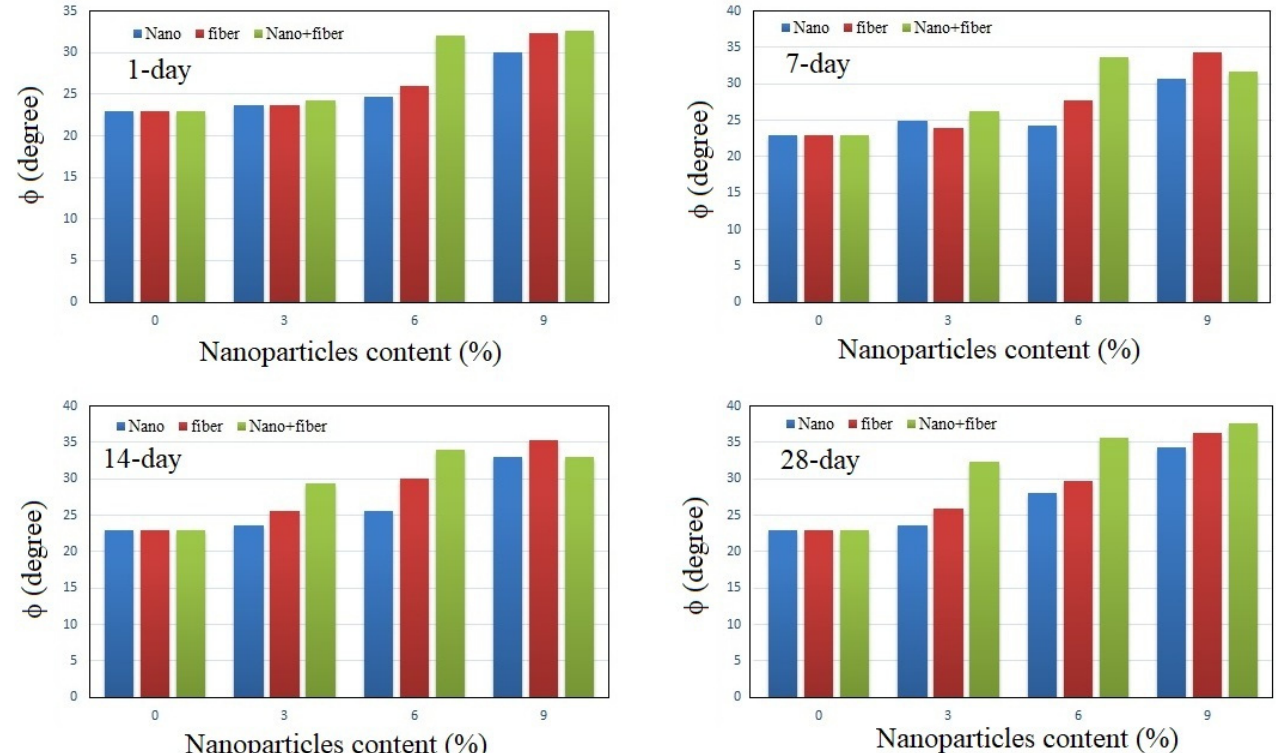
Figure 11. Estimated friction for a different group of samples.